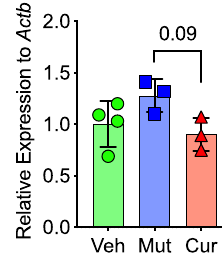
Figure 7. Functional characteristics of the gastrointestinal system ( A ) Gut barrier integrity was assessed by oral administration of FITC-Dextran and measuring its absorption in circulating blood 4 h later. No differences in serum FITC signal was detected between any groups. n = 8–10 per feeding group, males and females, randomly selected for the assay, one-way ANOVA. ( B ) There were no significant differences in whole-gut transit time at months 4, 5, and 6 between genotypes, sex or bacterial feeding groups measured as time taken (hours) to excrete carmine red dye administered orally. n = 8–10 per feeding group, males and females, randomly selected for the assay, one-way ANOVA. ( C ) Within the male hSOD1 cohort, mRNA expression of IL22 was decreased (trending) in curli-fed male hSOD1 mice compared to the mutant group, Kruskal–Wallis test, n = 3–4 per